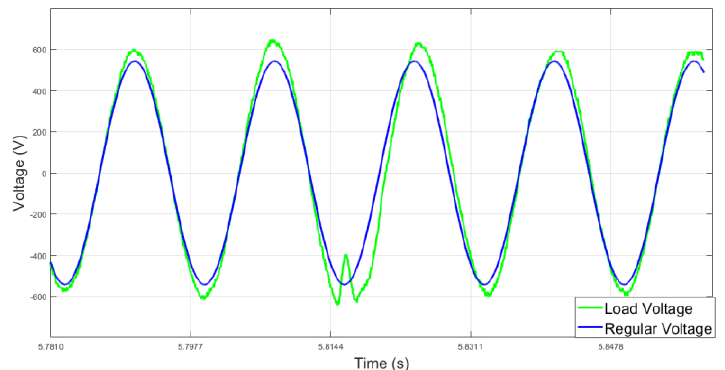
Figure 11. Stage 2: Backup on resistive loads — load voltage of analysis.